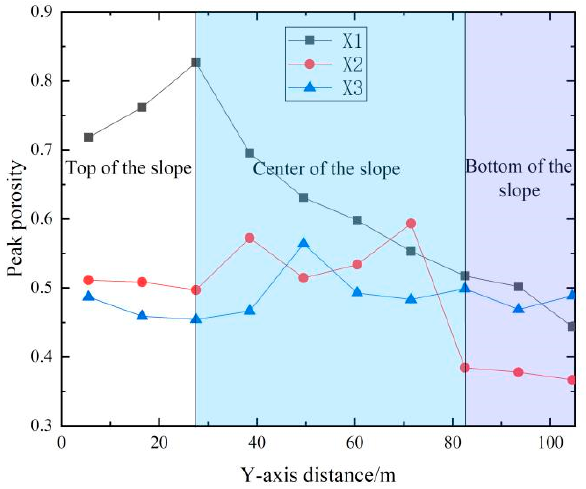
Figure 15. Overall slope peak porosity.